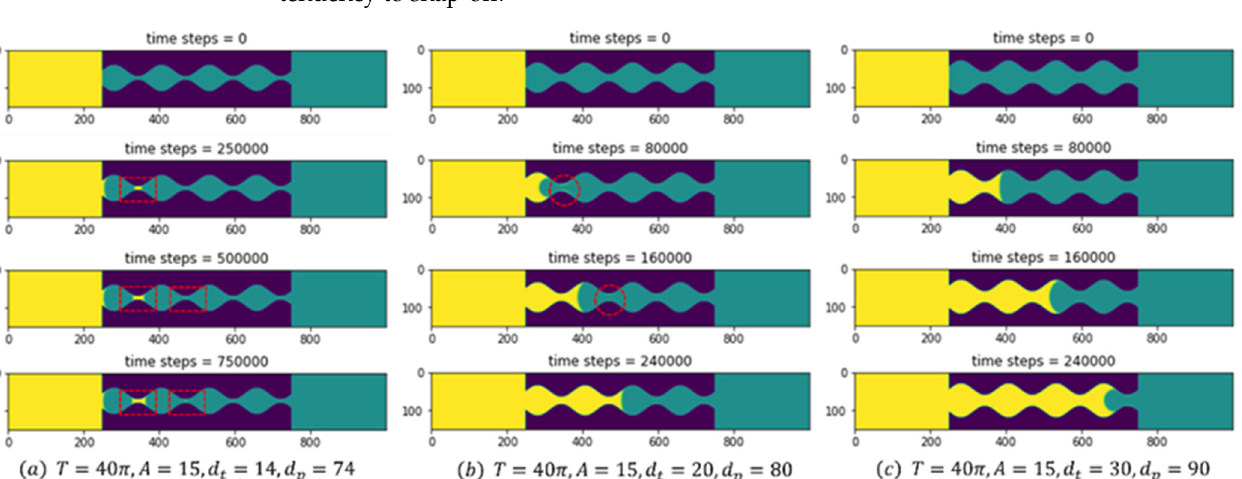
Figure 13. The snap-off phenomenon. To study the effects of capillary structures on the snap-off, we plotted the distribution of snap-off and non-snap-off phenomena to characterize the effects of the pore-throat as- pect ratio and the pore-throat tortuosity of the capillary on the snap-off, as shown in Fig- ure 12. The pore-throat aspect ratio and pore-throat tortuosity comprehensively reflect the capillary structure characteristics. We can see that there is a clear black boundary in Figure 14. Above the black dashed line, the snap-off occurs during spontaneous imbibition, whereas, below the dashed line, the snap-off does not occur. When the pore-throat tortuosity is constant, the larger pore- throat aspect ratio, the more likely that snap-off occurs. In addition, when the pore-throat aspect ratio of the variable-diameter capillary is constant, the pore-throat tortuosity is larger, and the snap-off is more likely to happen. Overall, the pore-throat aspect ratio and pore-throat tortuosity are highly relevant to the occurrence of snap-off. In addition, to further study the influence of diameter changes on the snap-off, we compared the spontaneous imbibition of three types of capillaries, as shown in Figure 15. The mean diameters of the three capillaries are the same, and the pore-throat tortuosity of the two curved capillaries are the same. It can be seen from Figures 15 and 16 that spon- taneous imbibition does not occur in the invariable-diameter capillary, but the phenome- non is completely different in the variable-diameter capillary.